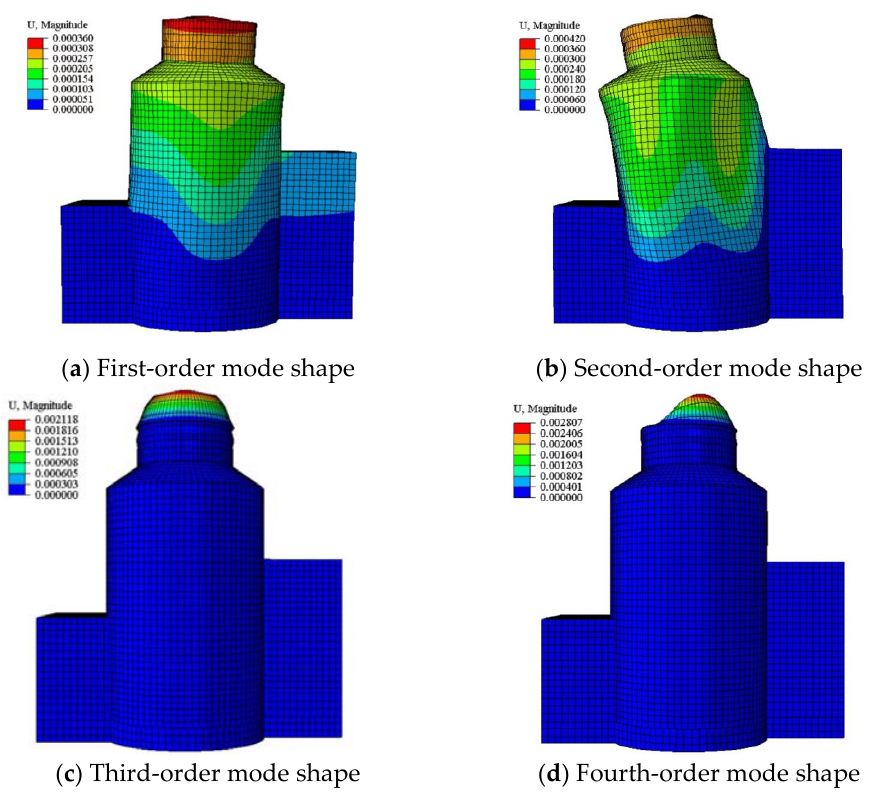
Figure 2. Finite element of the structure–soil–structure interaction.